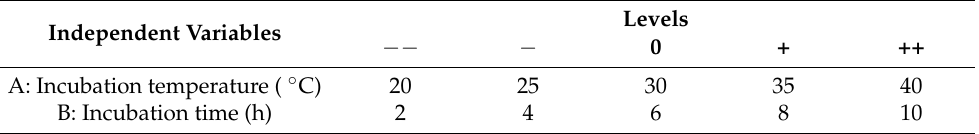
Table 4. Coded values of variables used in CCD for the optimization of cell-free synthesis of human TNF- α .